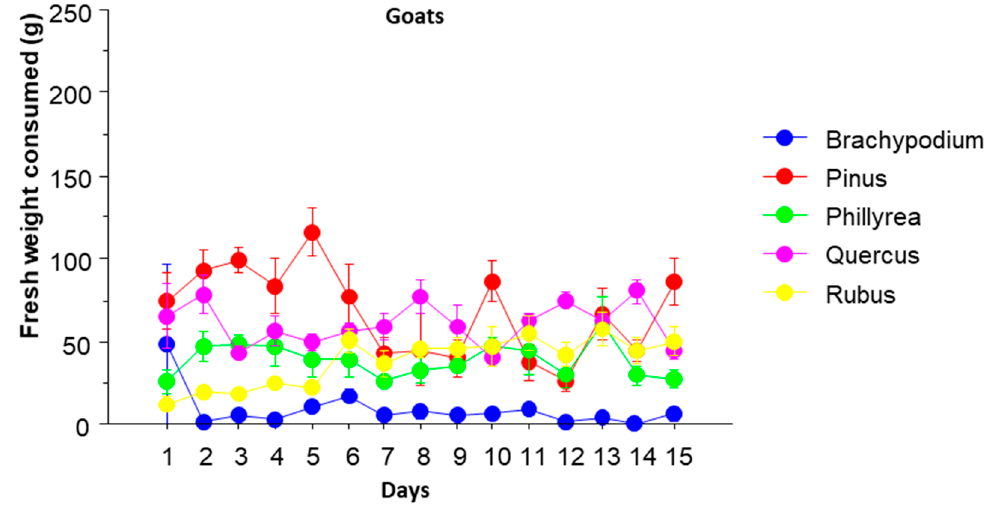
Figure 1. Daily average of fresh weight consumed by goats in the choice tests ( n = 7). Lines crossing the circles are standard errors.